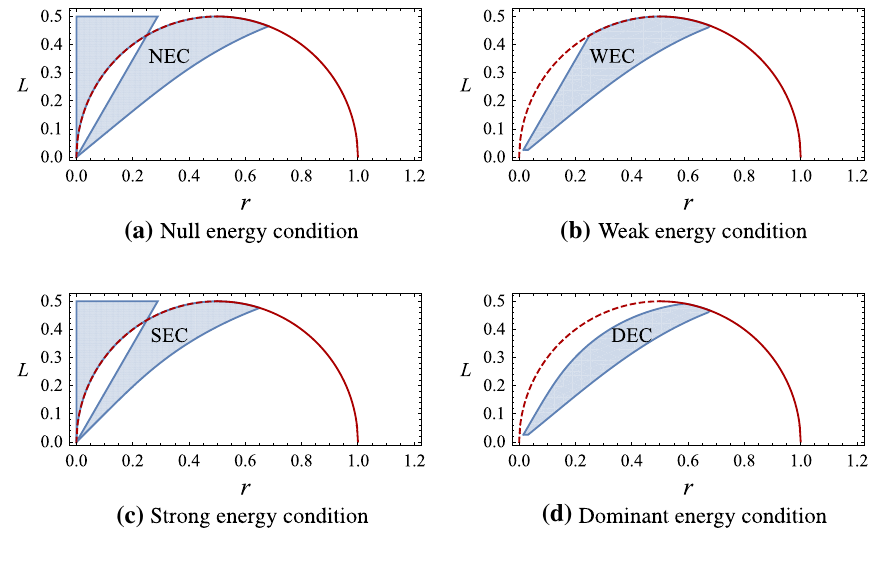
Note that the existence of horizons gives the constraint, L 2 ≤ 1 / 4, in